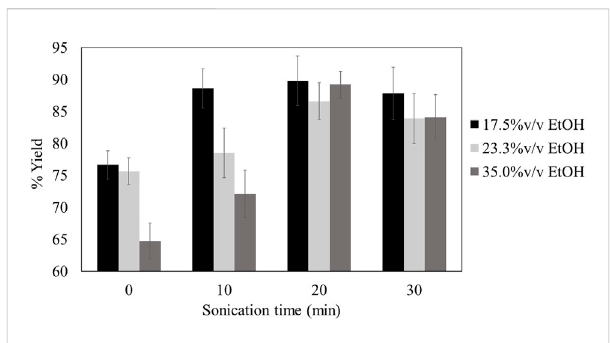
FIGURE 5 Organosolv lignin precipition yield at various solvent dilutions after assisted by sonication for different